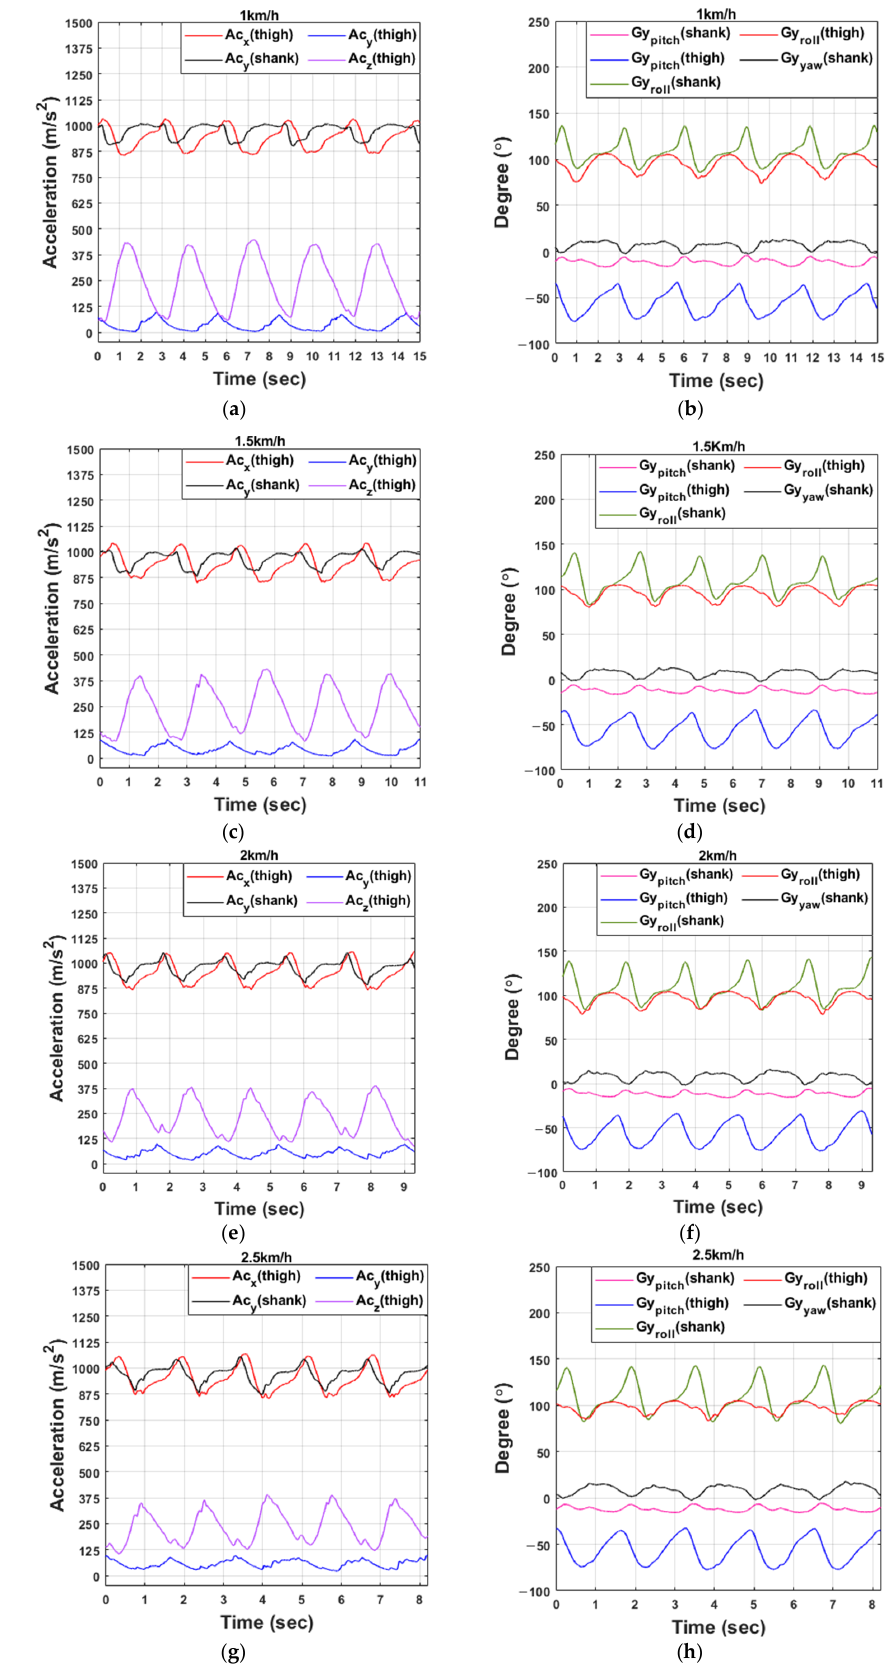
Figure 2. IMU sensor data obtained by walking on a treadmill: ( a , c , e , g ); accelerometer data: ( b , d , f , h ) gyroscope data. (From top to bottom, 1, 1.5, 2, and 2.5 km/h). Table 2. Accelerometer and gyroscope data according to the walking speed.